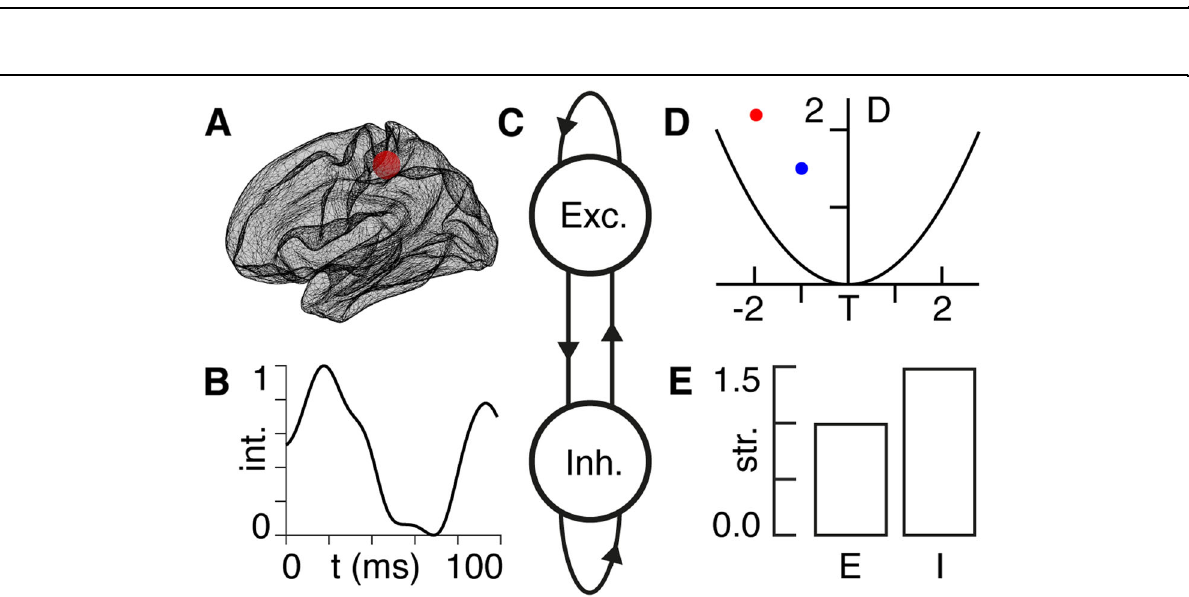
Fig. 2 Methodology overview. A We obtain measurements of neural activity in the primary somatosensory cortex — approximate location shown by the red region. B Using non-invasive neuroimaging techniques, we obtain a timecourse of neural signal intensity (int.) from the primary somatosensory region in ( A ) following an airpuff stimulus — shown here for the TRD patient in baseline condition in Fig. 1. C We model the region of interest in ( A ) in terms of a coupled E/I model (see Appendix I), where the excitatory (Exc.) and inhibitory (Inh.) component are connected — both to themselves, as well as to each other — as indicated by the arrows. D The strengths of the E/I connections in ( C ) allow us to summarise the dynamical behaviour of the timecourse in ( B ) being expressed by the region in ( A ) by plotting its location (blue dot) within the Poincaré diagram (see Appendix II) with the trace (T) on the x -axis and the determinant (D) on the y -axis. The red dot indicates a known location with the Poincaré diagram that we would like to shift toward by a change in E/I. E This bar chart shows the relative amounts by which we need to vary the strengths (str.) of the E/I signals in ( C ) in order to shift the dynamics from the blue (current) to the red (target) dot in the Poincaré diagram in ( D ). For this example, E does not vary (strength = 1) and I needs to increase by 50% (see Appendix III).